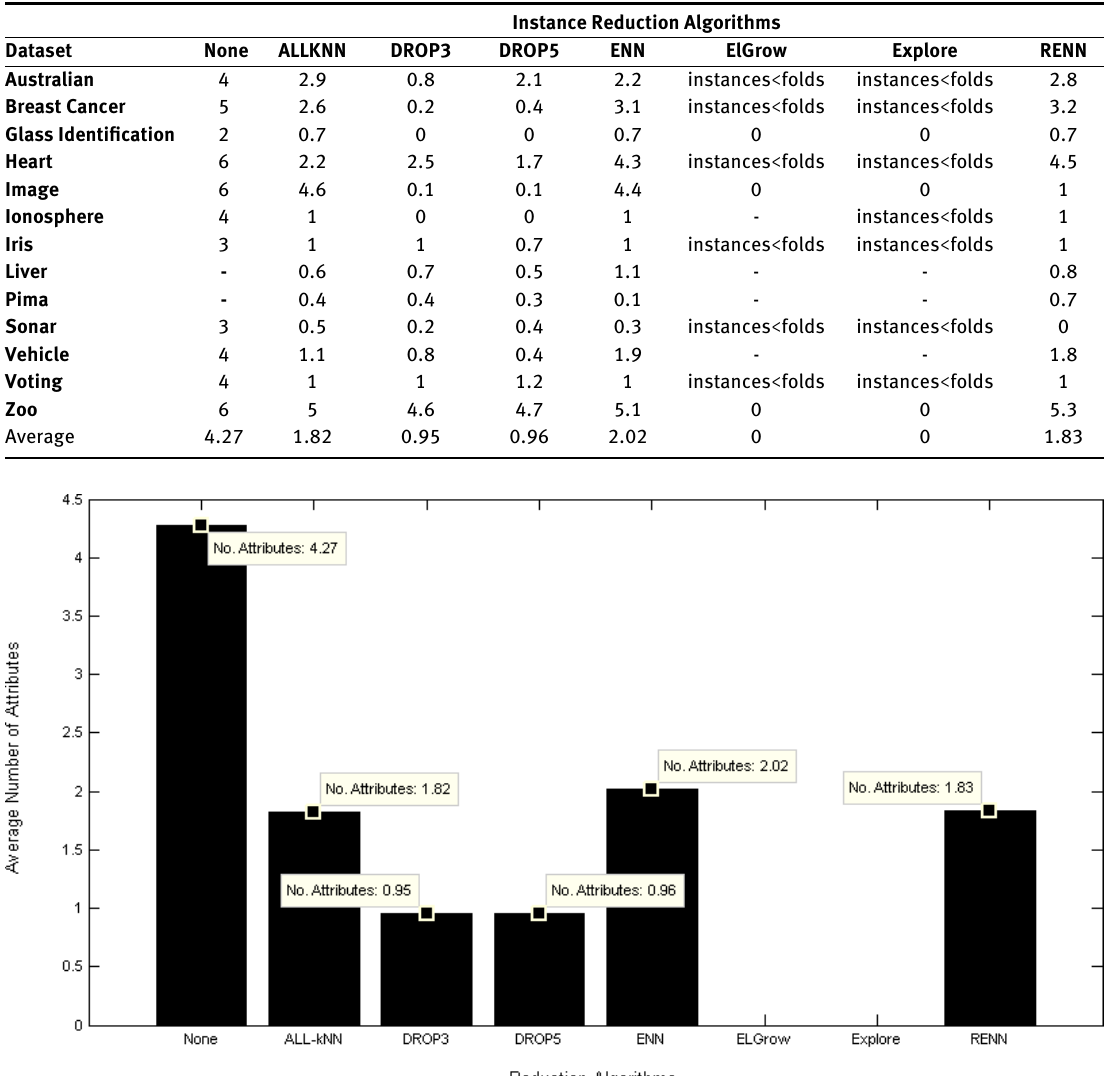
Figure 7: Average Number of Attributes for Pruned Trees With 0% Noise